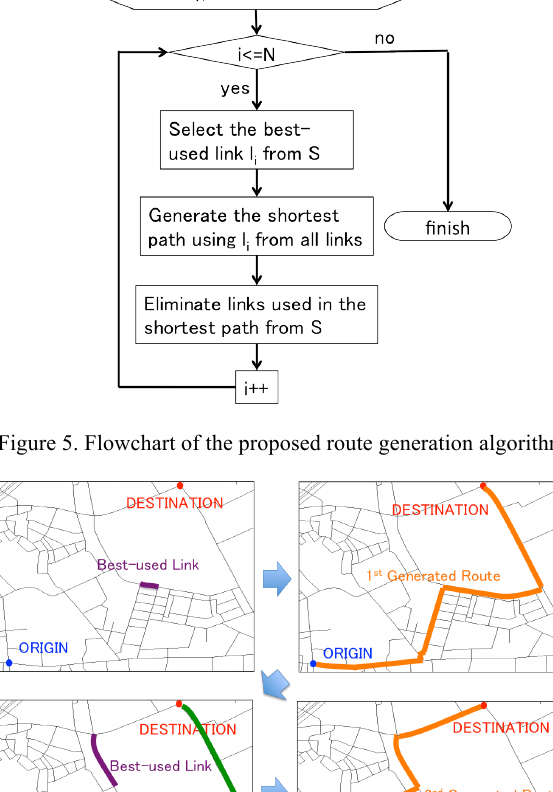
Figure 8. Single-day GPS data in the Tokyo and Shinjuku Area